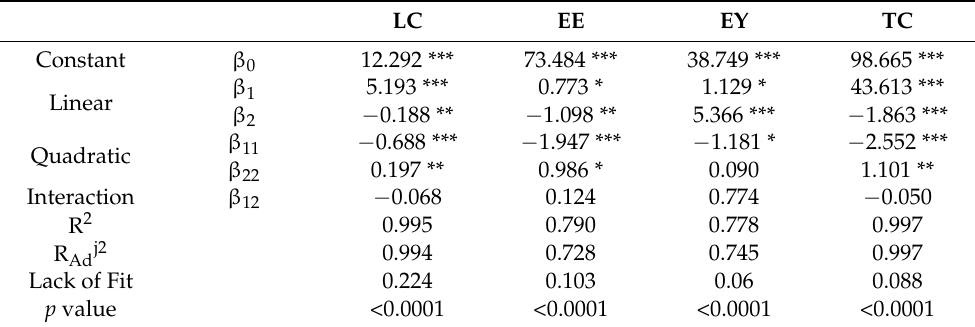
Table 3. Coded second-order regression coefficients, determination coefficients (R 2 and R 2 adj ), lack of fit, and p values of the fitted models on loading capacity (LC), encapsulation efficiency (EE), encapsulation yield (EY), and tannin content (TC) dependent